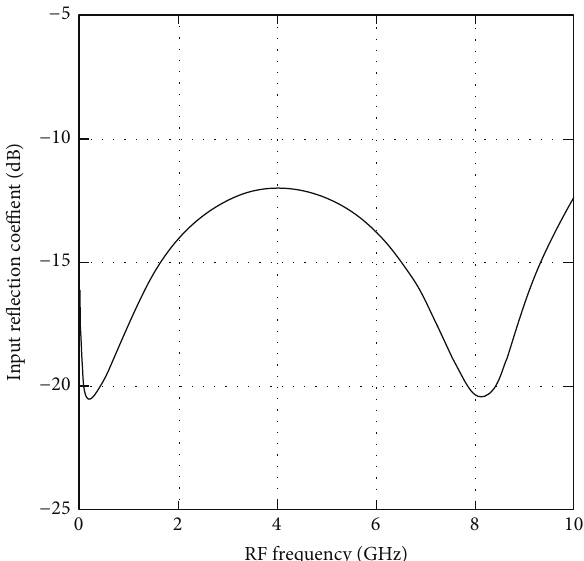
Figure 5: Simulated result of input return loss ( 𝑆 11 ).